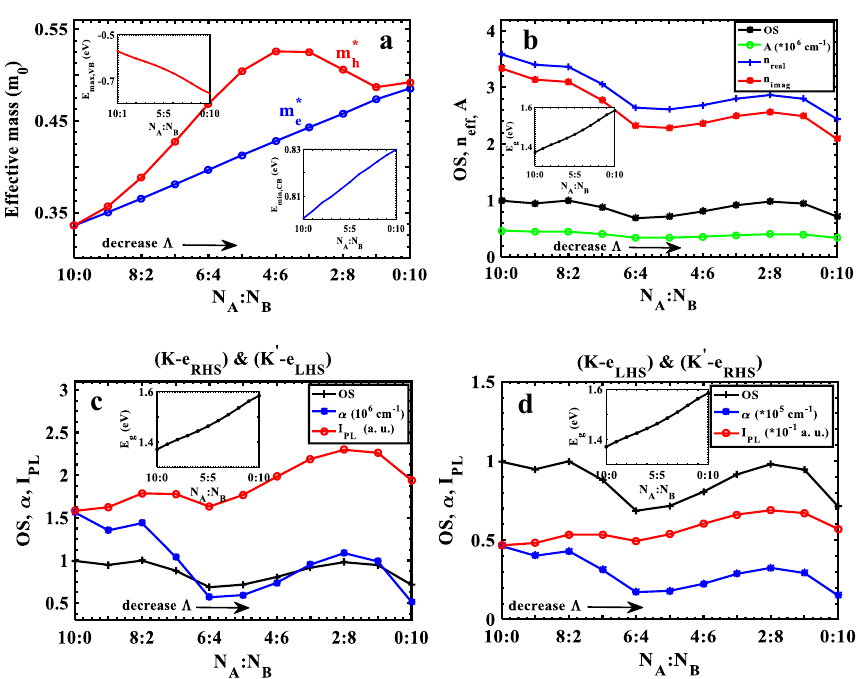
Figure 8. Electronic and optical characteristics of the TMDC-PSL versus the width ratio of the layers with SOC; ( a ) effective mass of carriers; ( b ) real (blue) and imaginary (red) effective refractive index, absorbance (green), and OS (black); Absorption coefficient and photoluminescence at K (cid:31) K ′ (cid:30) -valley with up and down spin for incident light polarizations of ( c